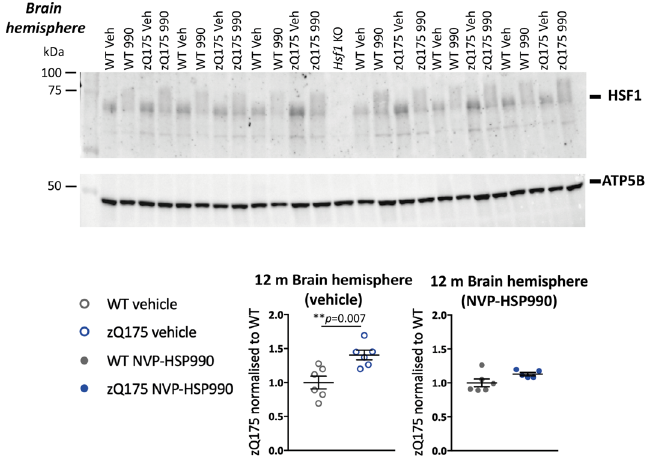
Figure 6. Neither basal nor activated levels of HSF1 are decreased with disease progression in zQ175 brain hemispheres. Western blot images showing HSF1 protein (top) or ATP5B (bottom) levels in brain hemispheres from zQ175 and wild-type mice treated with NVP-HSP990 or vehicle ( n = 5–6/genotype/treatment) at 12 months of age probed with HSF1 antibody 51034-1-AP (Proteintech). Quantification was performed separately for the vehicle and NVP-HSP990 treated samples and normalised to wild-type in each case. HSF1 levels were higher in zQ175 brains than in wild type under basal conditions. There was no difference in HSF1 levels after induction with NVP-HSP990 between the genotypes. Statistical analysis was by unpaired Student’s t test. Mean ± SEM. The test statistics can be found in Supplementary Table S13 online. Uncropped blots are presented in Supplementary Fig. S17 online. Veh vehicle, 990 NVP-HSP990, WT wild-type, m months, KO knockout, ant.